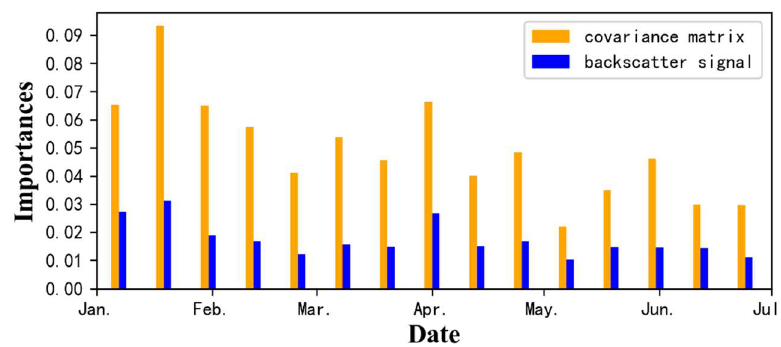
Figure 9. Importance validation with random forest (RF) classifier. The sum of the importance of all variables represented by each bar. For example, the first orange bar represents the sum of the importance of the four variables in the Sentinel-1 covariance matrix on January 5.